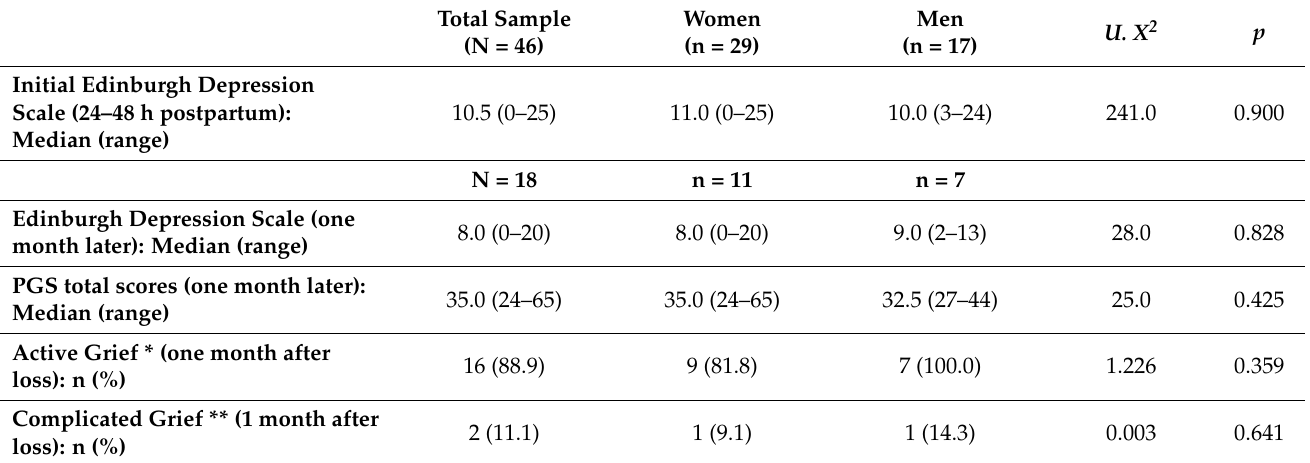
Table 2. Psychopathological characteristics of the sample (N =